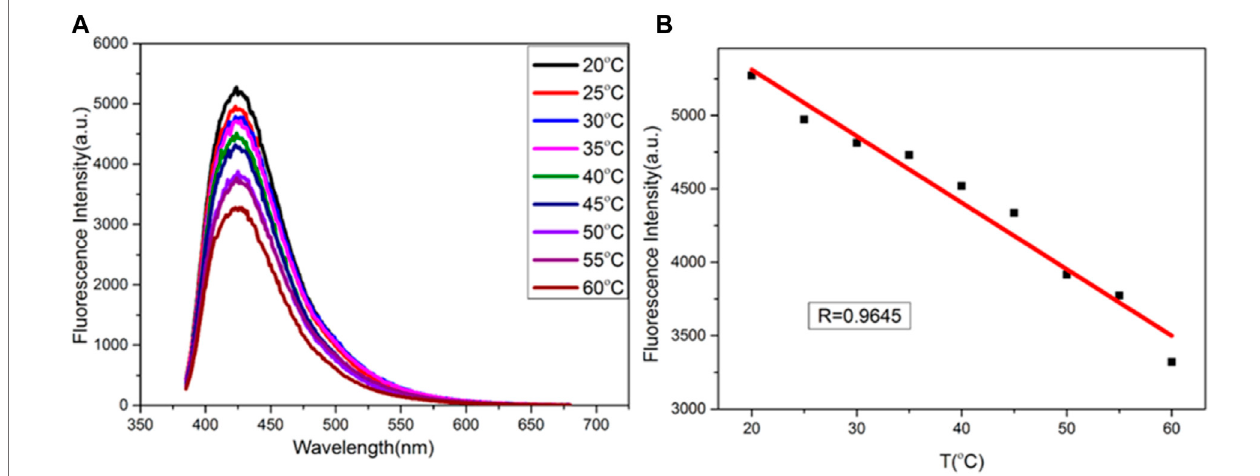
FIGURE7 | (A) Fluorescence spectra ofCuNPsobtained at different temperatures (from top to bottom: 20, 25, 30, 35, 40, 45, 50, 55, and 60 ° C,respectively); (B) relationship between F and temperature.